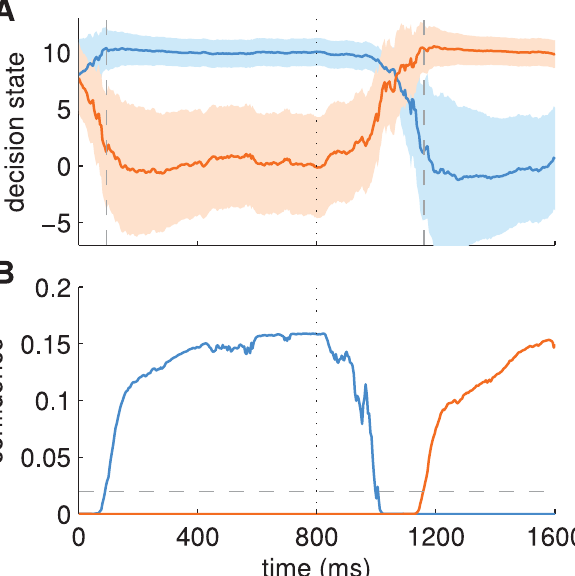
Fig 10. Example evolution of the posterior density of the decision state and the associated confidence values for one trial with a switch of stimulus at 800ms (vertical, dotted line). (A) Posterior density of the decision state with mean (coloured lines) and two times standard deviation (shading) of decision state variables as in Fig 8A. Grey, dashed lines in A show the decision times for the initial decision (92ms) and the re-decision after the switch (1160ms). (B) Solid lines indicate confidence values for both alternatives, i.e., the posterior probability density values that the decision state is in one of the stable fixed points of the attractor dynamics. The decision threshold is indicated as grey, dashed line. The parameters of the model were those of Fig 7B ( r = 2.4, s = 4, q = 0.5).